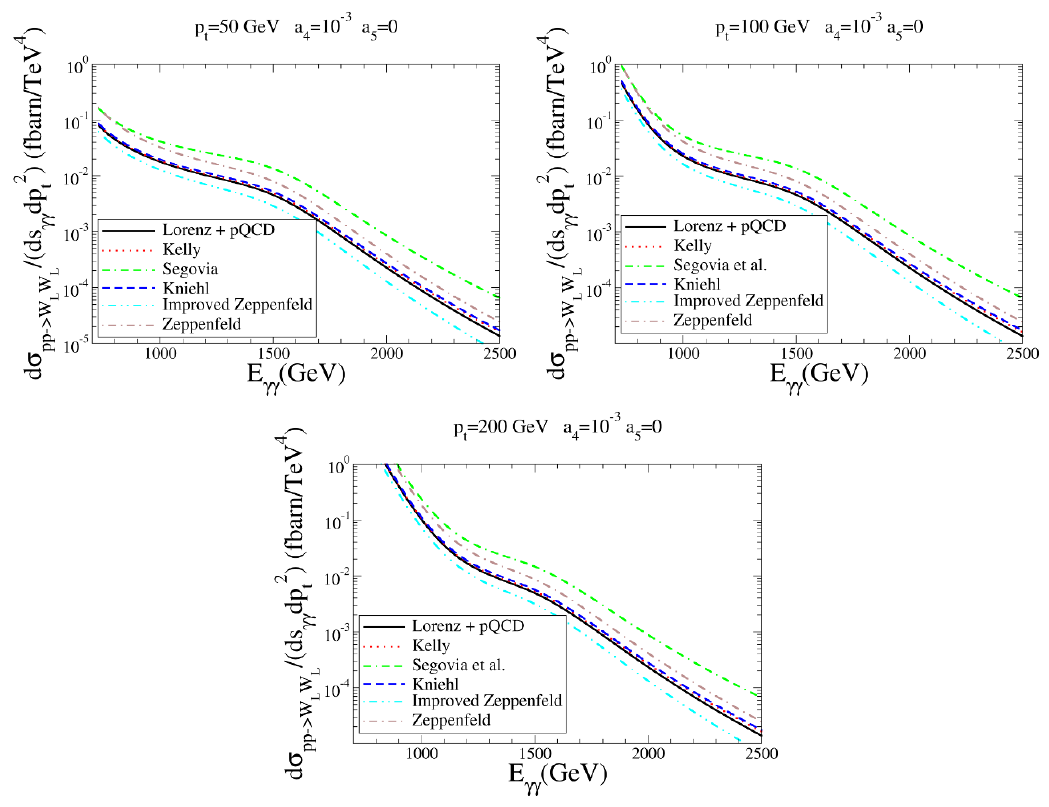
Figure 8 . Cross section for production of W L W L pairs via photon-photon fusion in pp collisions, with both protons elastically scattered. The indicated NLO HEFT parameter a 4 = 10 (cid:0) 3 injects a resonance of the EWSBS around 1 TeV. We show three di(cid:11)erent transverse momenta to show sensitivity to possible experimental cuts.